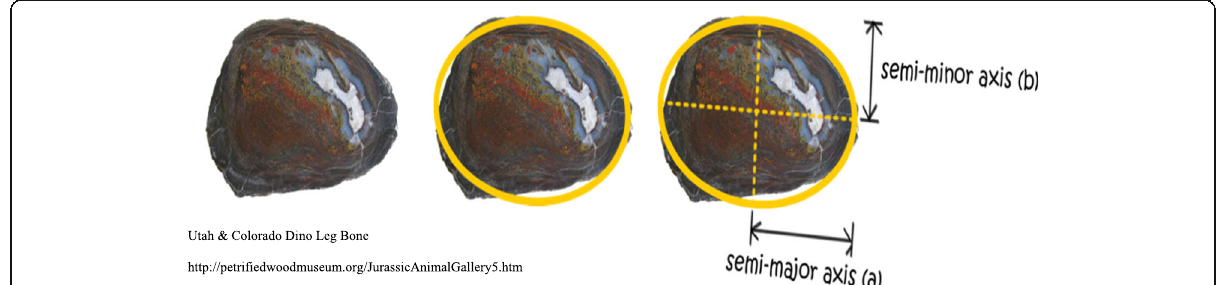
Fig. 4 Leg bone information obtained from the Internet and geometrical modeling used to estimate the